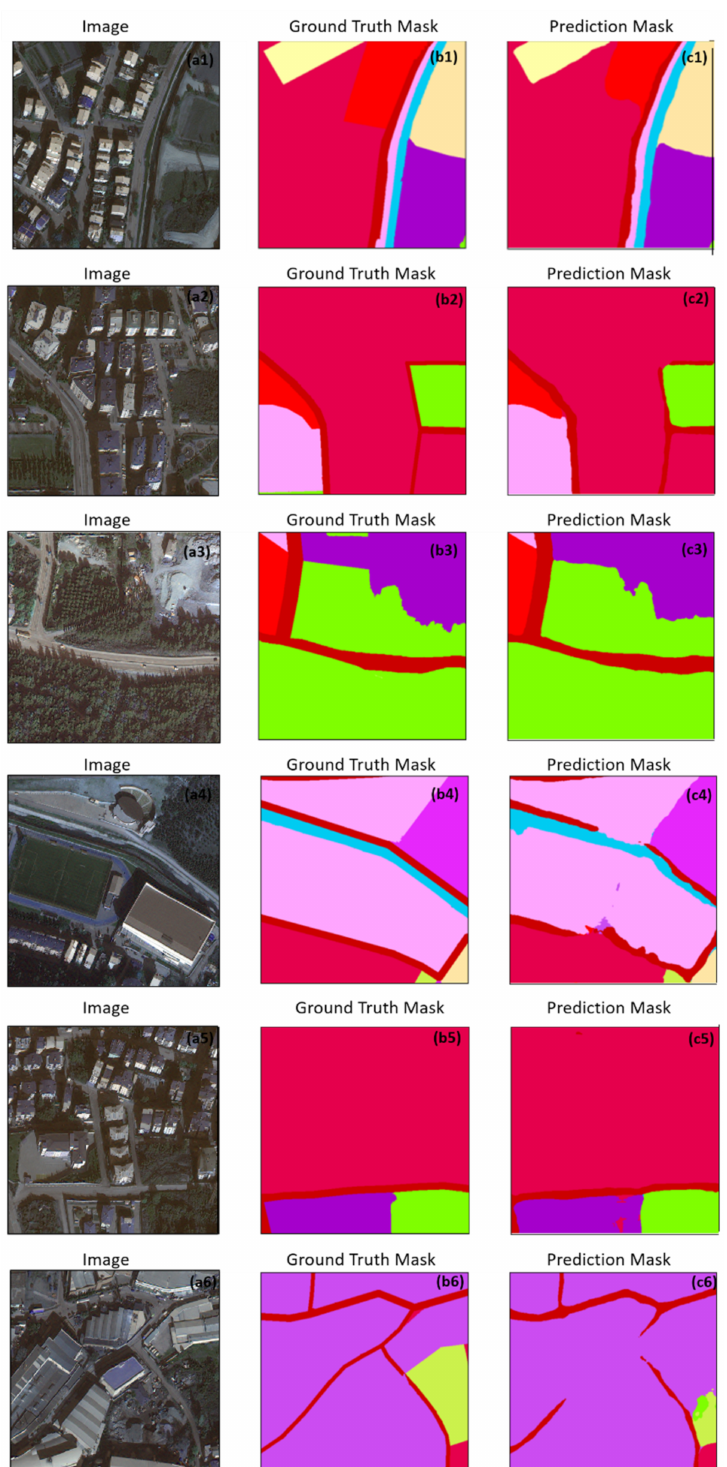
Figure 8. Qualitative results of the classifier trained on the Kestel dataset. ( a1 – a6 ) show original image patches; ( b1 – b6 ) illustrate the corresponding Ground Truth masks, and ( c1 – c6 ) show the prediction results with the proposed